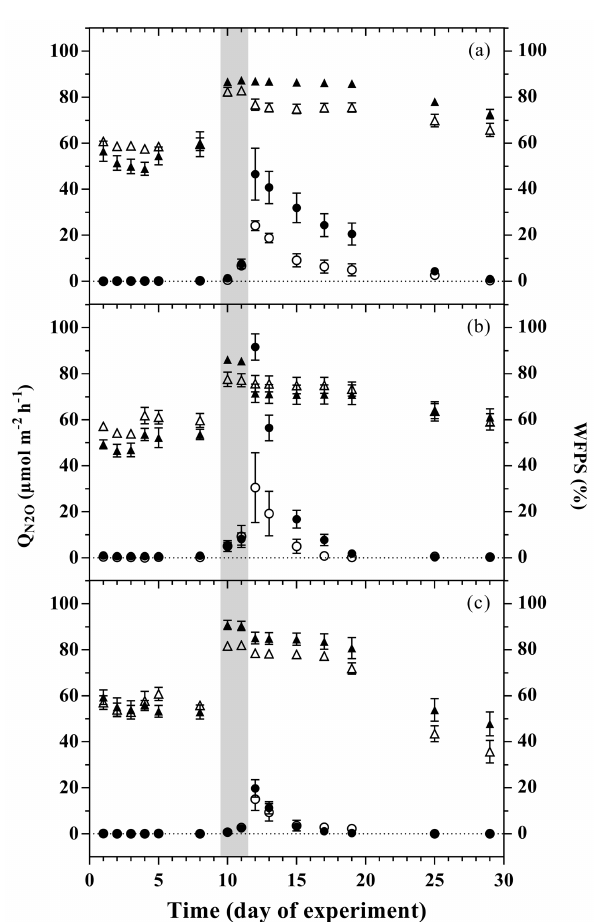
Figure 2. Mean N 2 O emission during the flooding–drying experi- ment from large-aggregate model soil (LA; filled circles) and small- aggregate model soil (SA, open circles). The corresponding water- filled pore space (WFPS) in LA (filled triangles) and SA (open tri- angles) are depicted on the right y axis; unamended soils (a) , litter addition (b) and plant treatment (c) . Flooding phase indicated by the grey area. Symbols indicate means; error bars are SE; n =